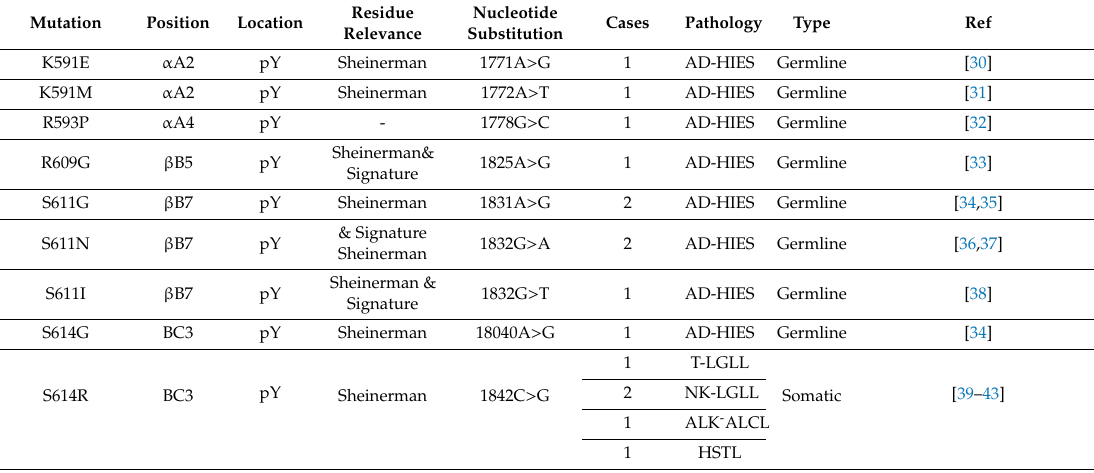
Table 1. Disease-associated mutations in the STAT3 SH2